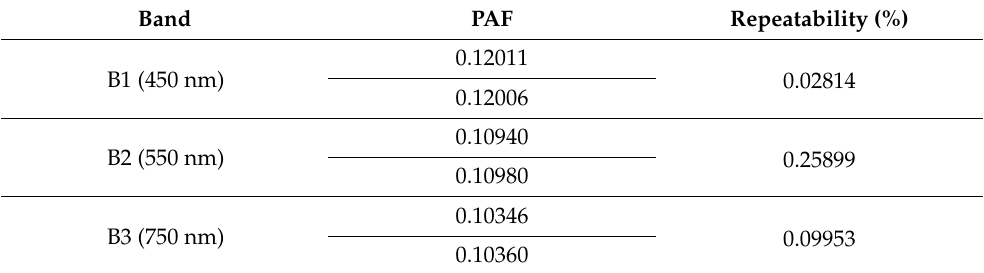
Table 2. The PAF of the AGRI.